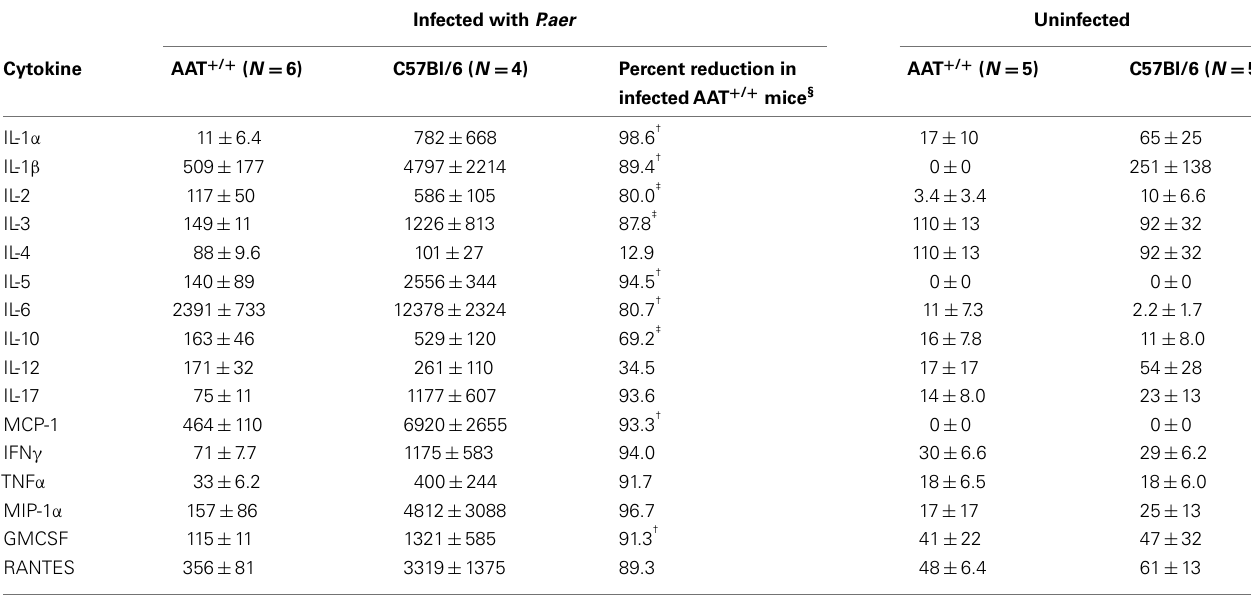
Table 2 | Serum cytokine levels inAAT + / + and C57Bl/6 control mice * .